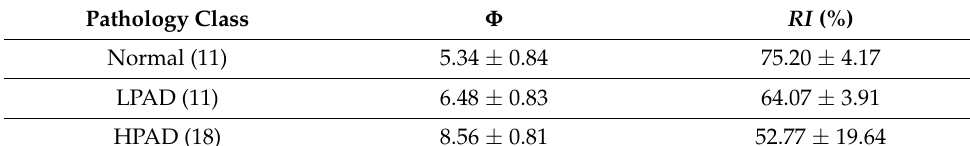
Table 1. Preliminary results for screening normal, LPAD, and HPAD.